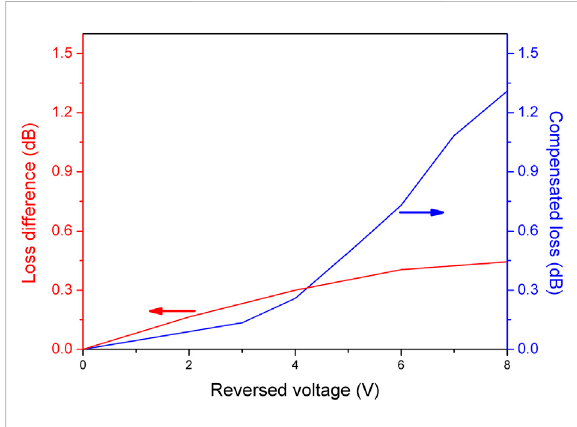
FIGURE 5 The loss difference bytwo arms of2ndand thecompensated loss offered by 1st-1 and 2 as functions of the reversed voltage.